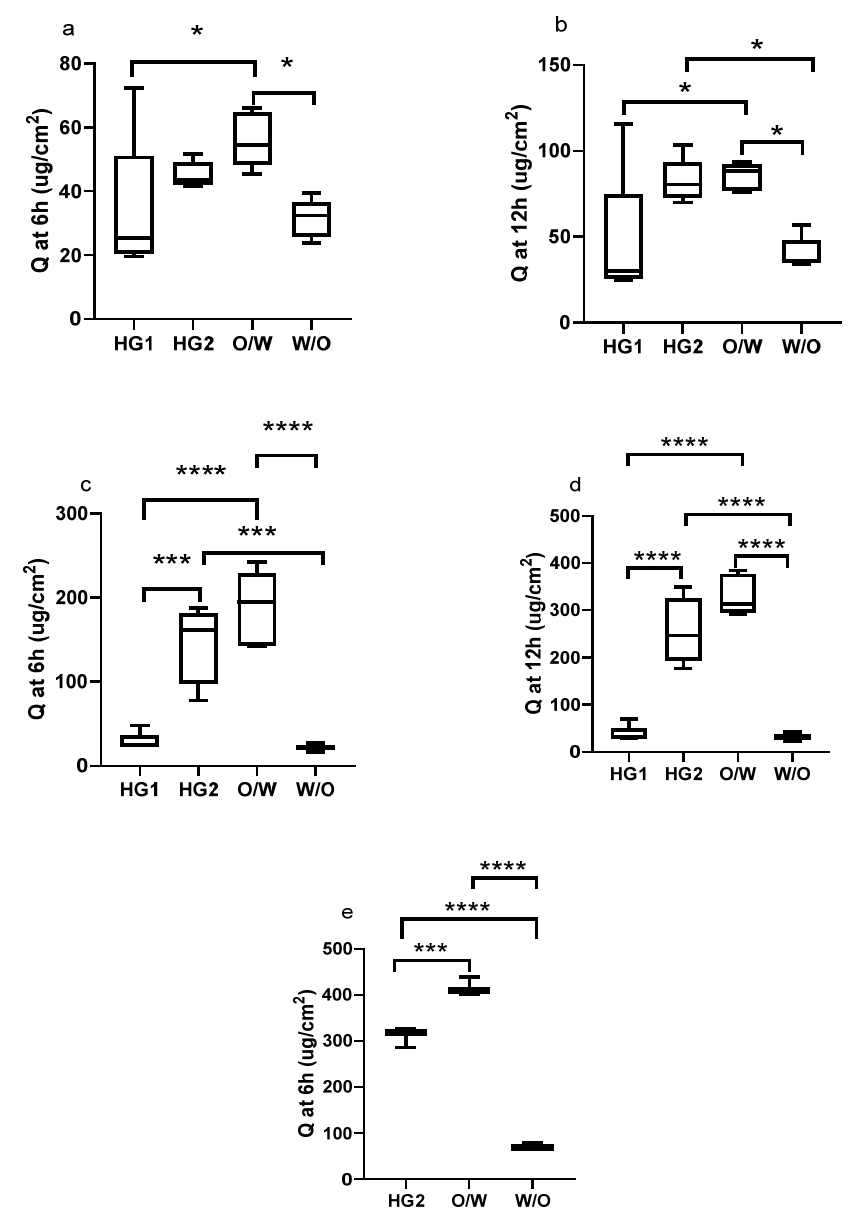
Figure 2. Box diagrams of the permeated drug amount (at 6 and 12 h) from different formulations using HSE ( a , b ), Strat-M ( c , d ), and Skin PAMPA ( e ) membranes. (* p < 0.05, *** p < 0.001, **** p < 0.0001).